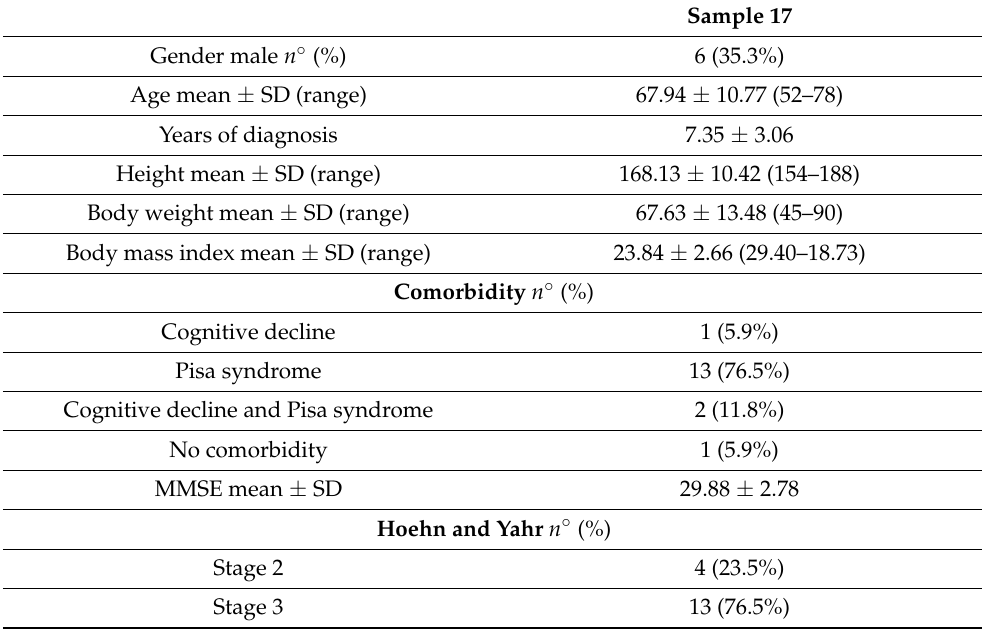
Table 1. Demographic characteristics of the 17 individuals with Parkinson’s disease participating to the Equine therapy